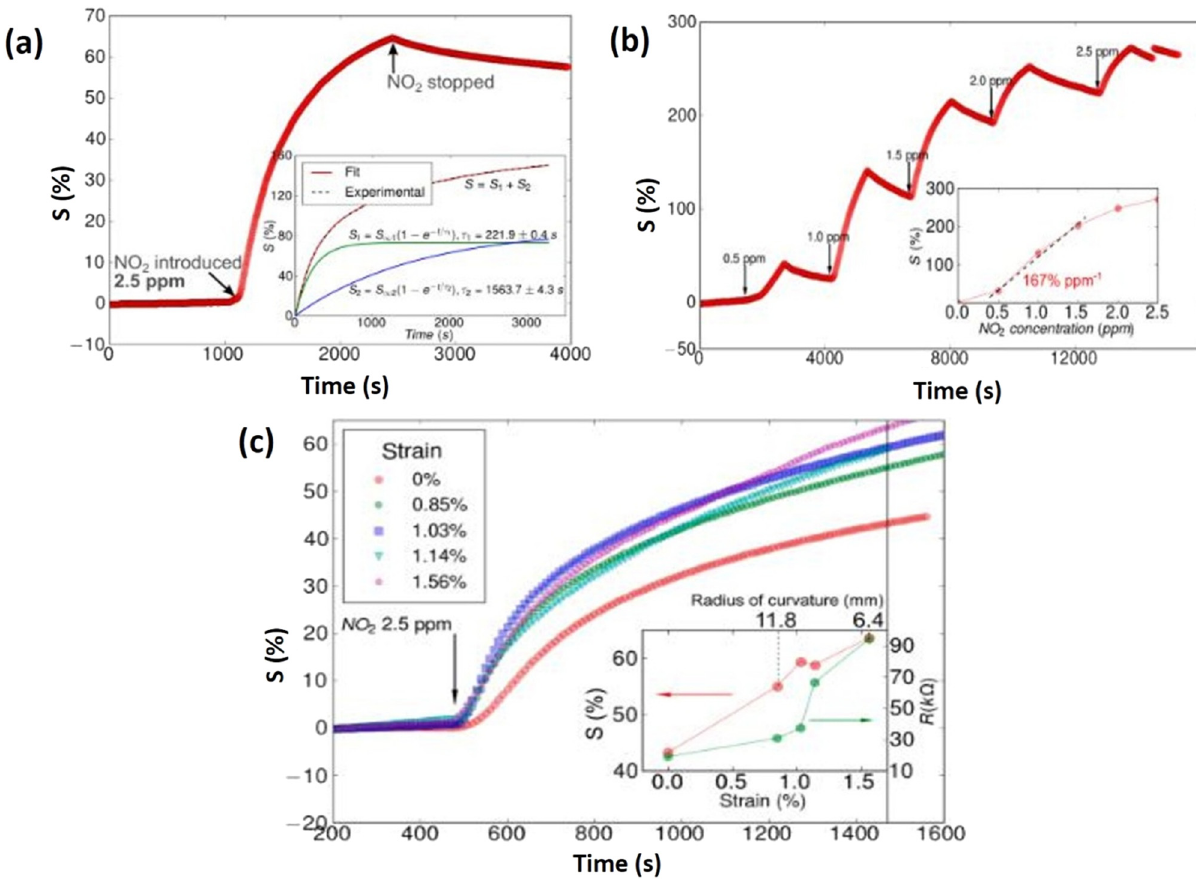
Figure 11: ( a ) Change in conductance of a graphene paper strip to 2.5 ppm of NO 2 . The inset shows a fi t of double exponential function to the temporal response for 2.5 ppm of NO 2 , ( b ) change in conductance of a graphene paper as concentration of NO 2 increases starts from 0.5 to 2.5 ppm. The inset shows the plot of response at t = 1,000 s vs the concentration of NO 2 , which has a slope of 167 ppm − 1 at the start ( indicated by dashed line ) and ( c ) change in conductance of a graphene paper as strain is applied at 2.5 ppm of N NO that both the baseline resistance and response of the strip increase with increasing strain. Reproduced from ref. [ 106 ] .